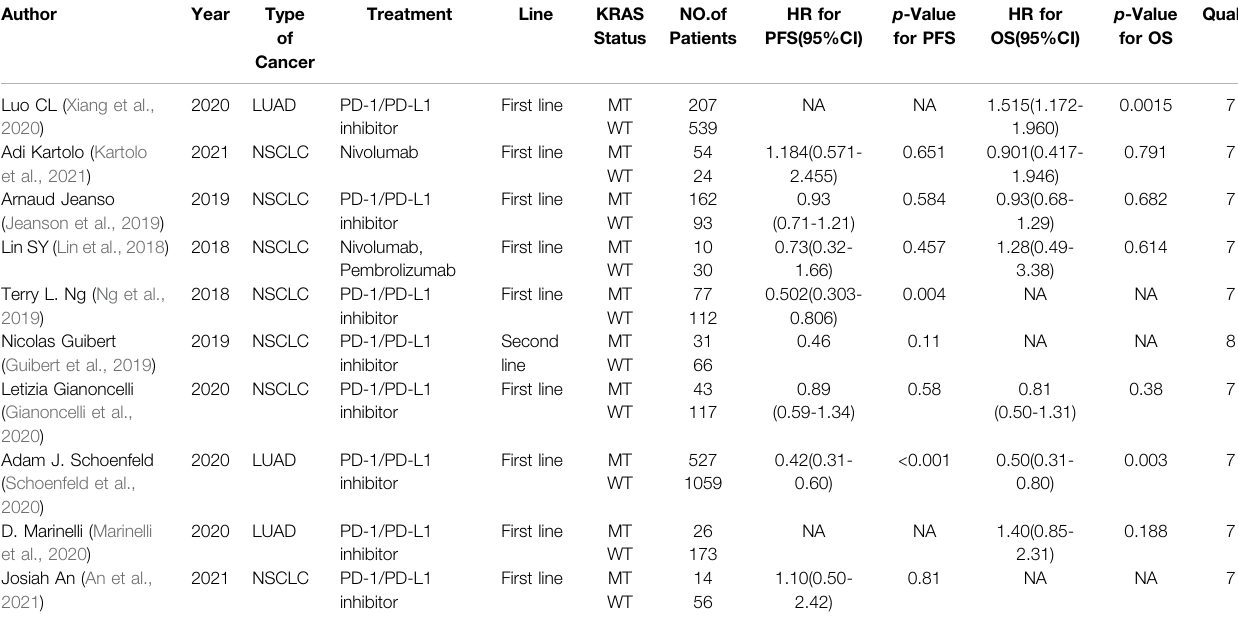
TABLE 1 | Basic characteristics of included studies with KRAS